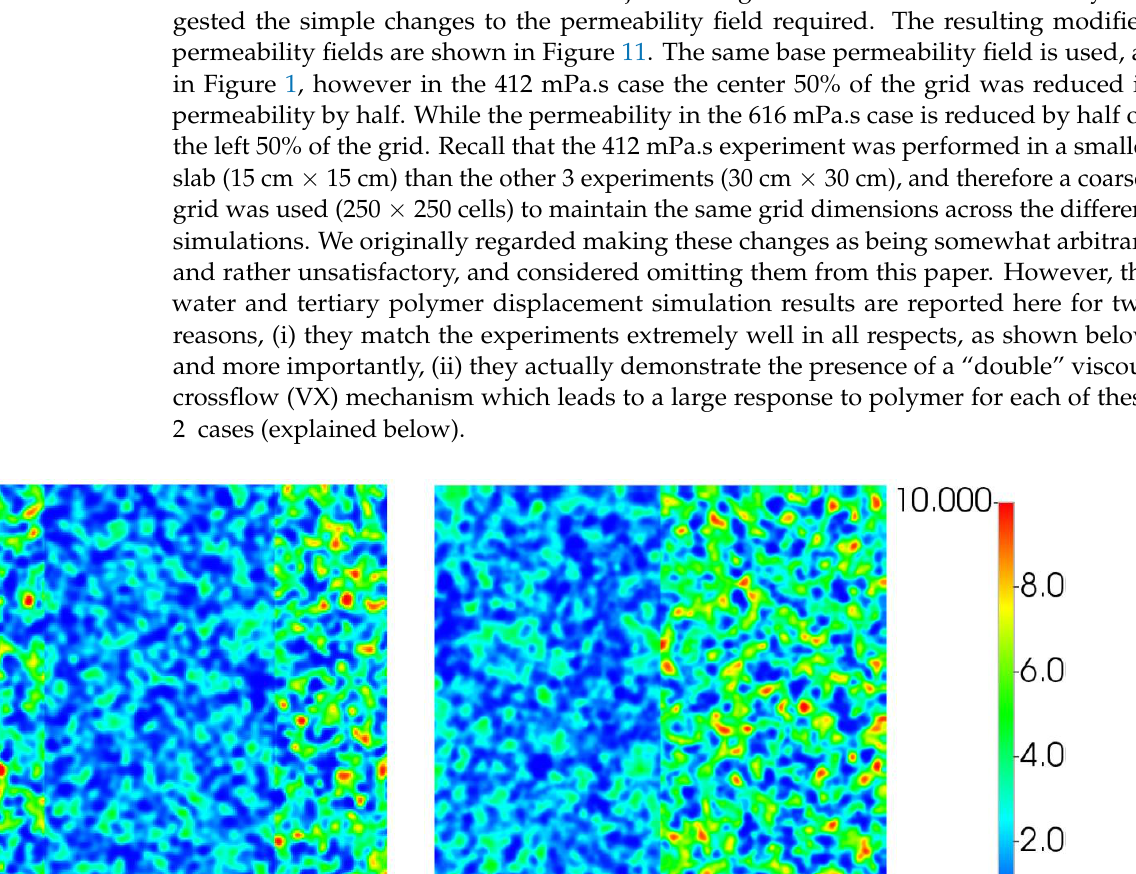
Figure 12. Simulation match of the unstable displacement of 412 mPa.s oil ( left ) and 616 mPa.s oil ( right ). It can be seen that a very good (but not perfect) match between experiment and sim- ulation is obtained for both floods for the oil recovery, water cut, and pressure profiles. The corresponding finger patterns observed in the simulation vs. experiment are pre- sented in Figure 13 for the 412 mPa.s case and Figure 14 for the 612 mPa.s case. By study- ing the animations of the evolution of the finger patterns, the water/oil saturations, and the oil banking, it became clear what mechanisms led to the very high IR values for the polymer response described above (IR~100%). The animations of water saturation against time are supplied as supplementary material with this paper and may be downloaded from the journal website (Videos S1 – S4).